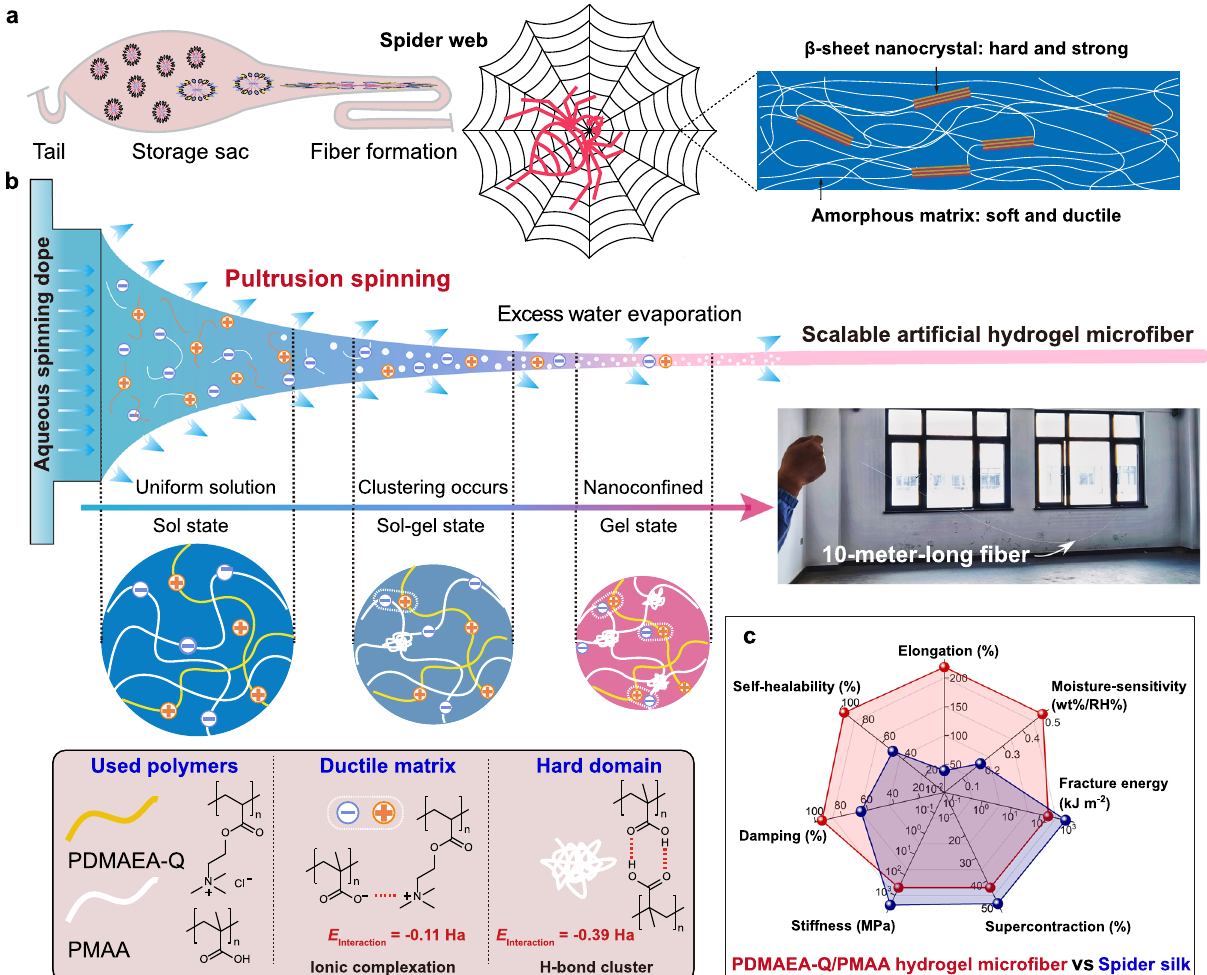
Fig. 1 | Schematic aqueous pultrusion spinning ofrobust hydrogelmicro fi bers with hydrogen bond nanocon fi nement. a Schematic spider spinning into high- performance silks with a hierarchical nanocon fi nement structure that consists of highly conserved β -sheet nanocrystals as hard and strong domains as well as soft and ductile amorphous matrix. b Schematic continuous pultrusion spinning of PDMAEA-Q/PMAA hydrogel micro fi bers with spider silk-like nanocon fi nement. With excess water evaporation at ambient conditions (25 °C, RH 60%), the gradual self-association of PMAA chains takes place generating high-density H-bond clus- ters embedded in the ionically complexed hygroscopic PDMAEA-Q/PMAA matrix.